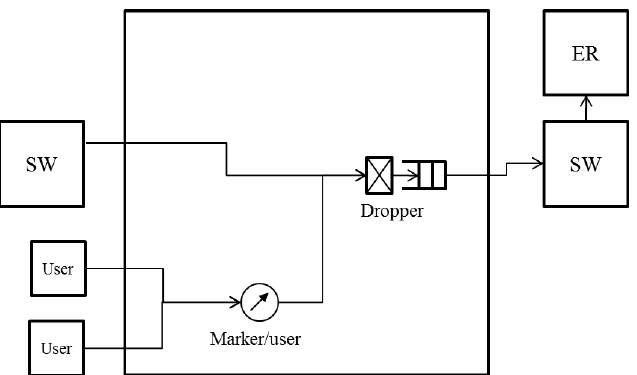
Figure 3. Node architecture for employing existing NRN + 1CM in a ring aggregation network with a single